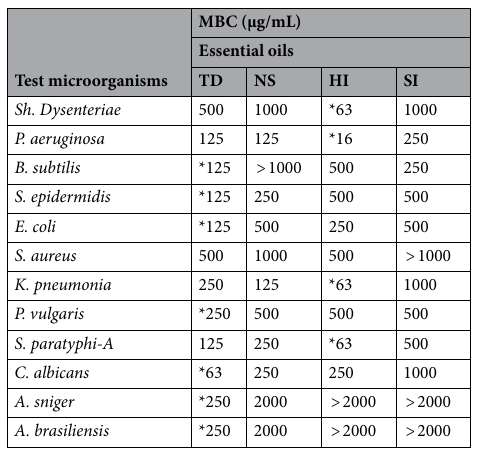
Table 4. MBC obtained using the essential oils from Thymus daenensis (TD), Nepeta sessilifolia ( NS), Hymenocrater incanus (HI), and Stachys inflata (SI) . Symbols (*) indicate values statistically different from the others essential oils against the same bacterial/fungal strain (p <